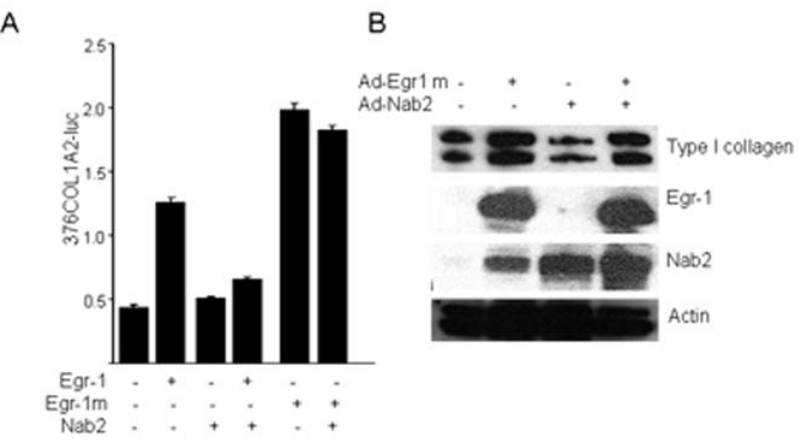
Figure 3. Nab2 blocks Egr-1-dependent collagen stimulation. A. Foreskin fibroblasts were cotransfected with expression vector for wildtype or mutant Egr-1 along with Nab2 or empty vector, and 376COL1A2-luc_reporter constructs. Following incubation of cultures for 24 h, cell lysates were prepared and assayed for their luciferase activities. Results, normalized with Renilla luciferase, are expressed as means 6 S.D. of triplicate determinations. *p , 0.005. B. Foreskin fibroblasts were infected with Ad-Egr-1m along with Ad-Nab2. Following 24 h incubation, whole cell lysates were prepared and subjected to Western analysis. Representative immunoblots.